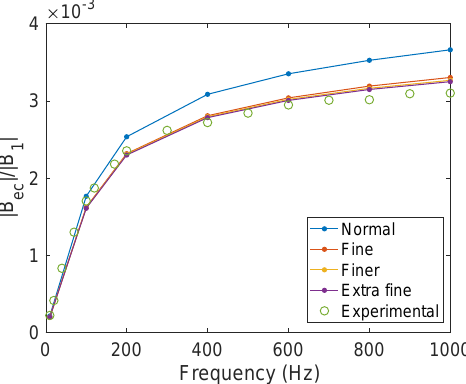
Figure A1. Experimental and simulated magnetic field ratio ( | B ec | / | B 1 | ) for solid aluminium cylinders with different mesh sizes: normal = 11,394; fine = 21,634; finer = 55,144; extra-fine =